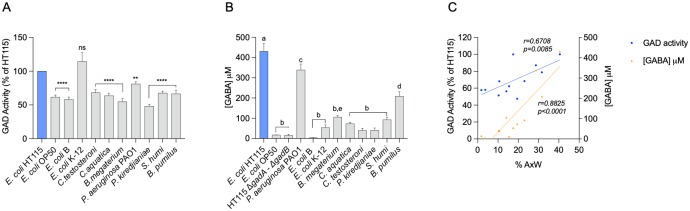
GAD activity and GABA levels correlate with neuroprotection conferred by other bacteria.Measurements of GAD enzyme activity normalized as a percentage of HT115 GAD activity (A) and GABA concentration found in pellets (B) in all bacteria used. (C) Correlation between GAD activity and GABA concentration in bacteria diet and percentage of wild-type axons in C. elegans. ****P < 0.0001, **P < 0.005; ns. “a,” “b,” “c,” and “d” are used to indicate statistically significant differences. The underlying numerical data and statistical analysis for each figure panel can be found in S1 and S2 Datasets, respectively. GABA, γ-aminobutyric acid; GAD, glutamate decarboxylase; ns, not significant.